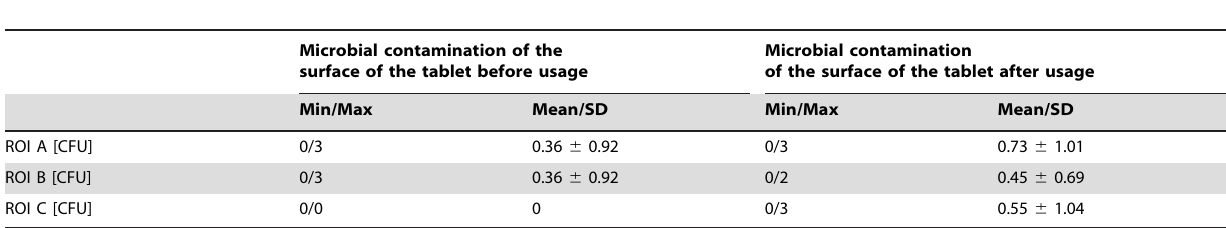
Table 3. Microbial contamination (colony forming units = CFUs) of the surface of the tablet computer was determined twice every day, before initial and after final usage (100 users in 11